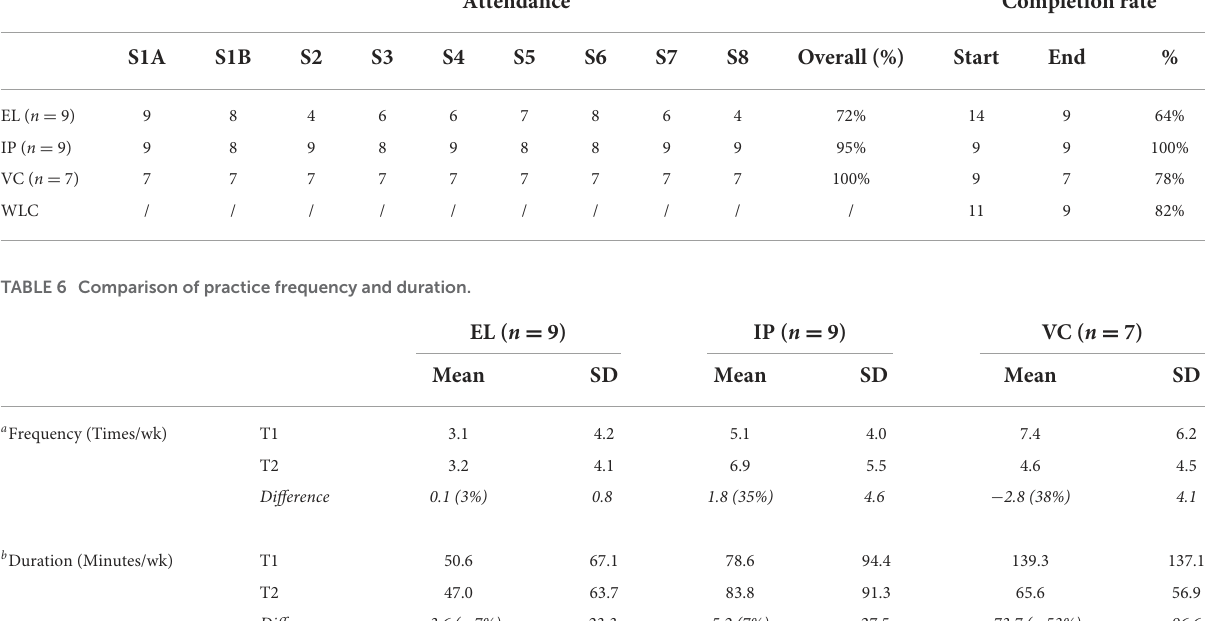
TABLE 5 Attendance of EL, IP & VC groups in each session and completion rate of all groups.